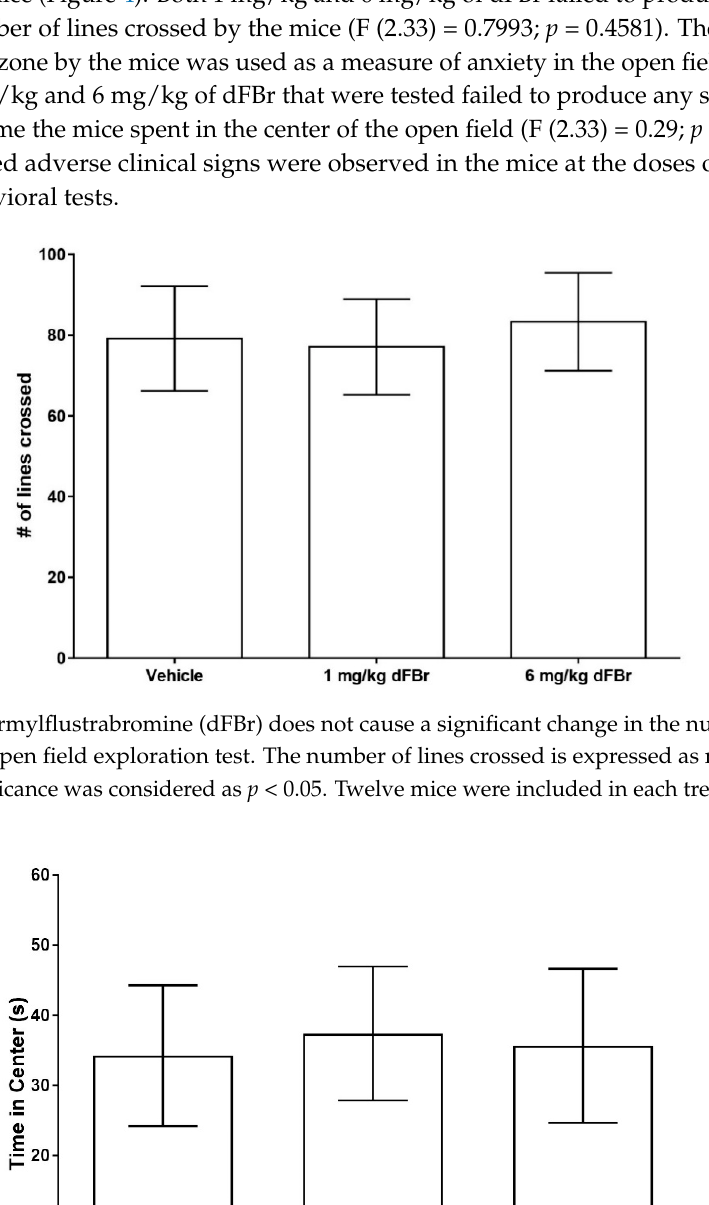
Figure 3. Desformylflustrabromine significantly decreases the number of writhes in the writhing test. The number of writhes is expressed as mean (±S.D.). Statistical significance was considered as * p < 0.05. Twelve mice were included in each treatment group ( n = 12).